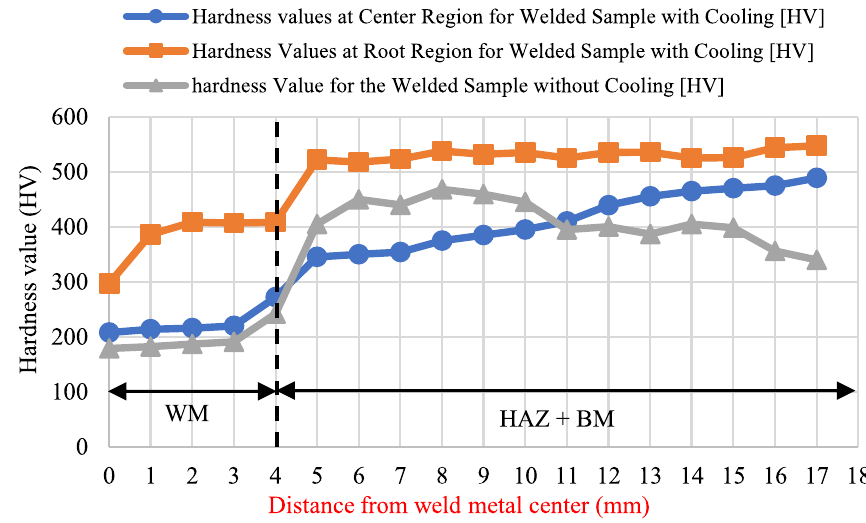
Fig. 18 Hardness distribution in the specimen welded using AWS A5.9 ER307 and joint a single bevel